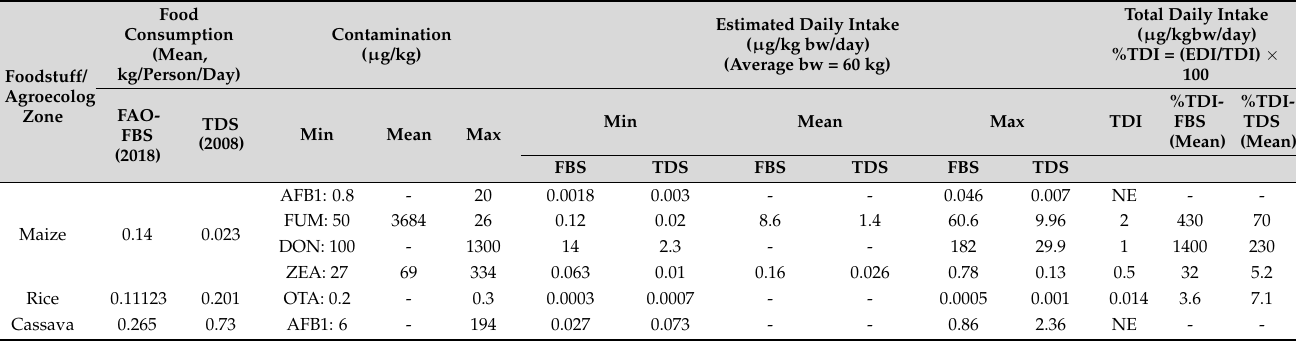
Table 3. Dietary exposure to mycotoxins through the consumption of contaminated foods in Cameroon. Expected intake compared to health guidance